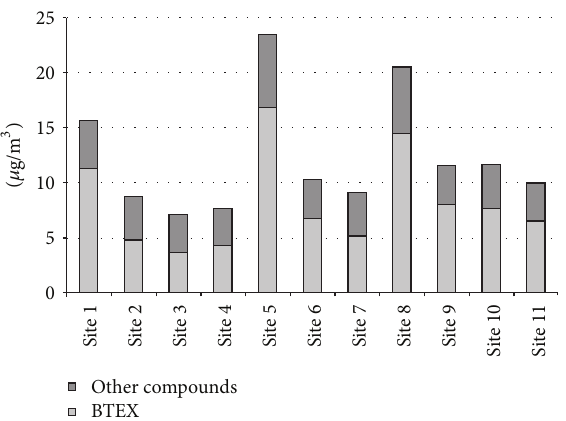
Figure 2: Trend of VOCSum, differentiated among BTEX and other compounds, in all monitored